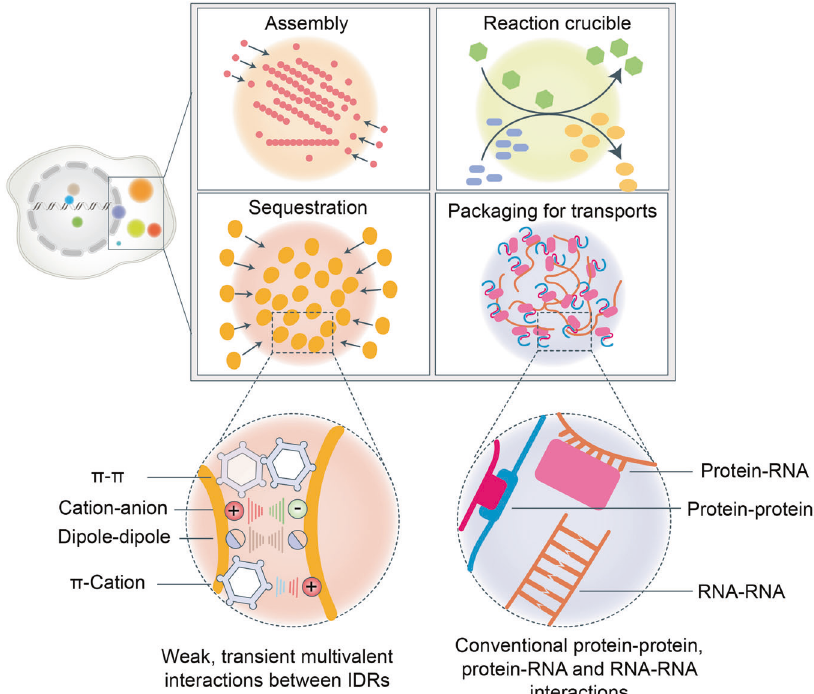
Fig. 2 The forces driving LLPS. There are several functions of biomolecular condensates, including the assembly of a large complex, as a reaction crucible promoting biochemical reaction, sequestration of speci fi c proteins to inhibit or promote some reaction, and packaging for transports. Besides, there are two types of multivalent interactions that contribute to LLPS. One is conventional multivalent interactions between protein and protein, protein and RNA, or RNA and RNA. The other is weak, transient, multivalent interactions between intrinsically disordered regions (IDRs), including π – π interactions, cation – anion interactions, dipole – dipole interactions, and π – cation